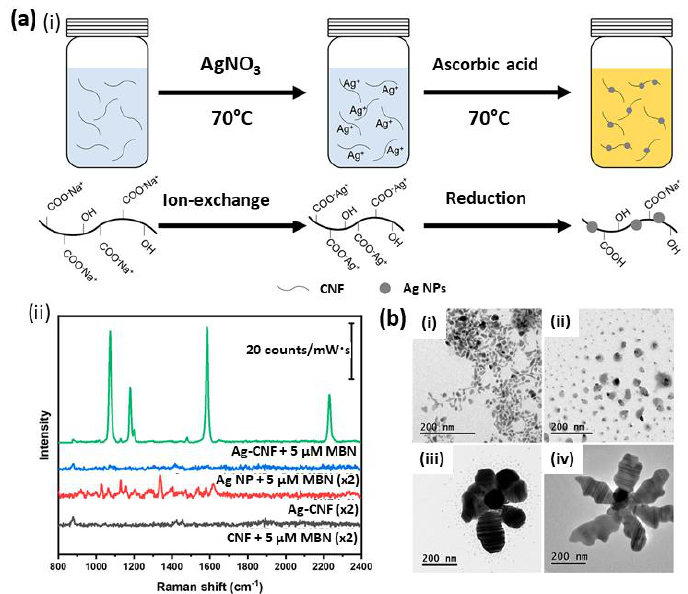
Figure 4. ( a ) Schematic representation of the in-situ synthesis of cellulose nanofibers (CNFs) decorated